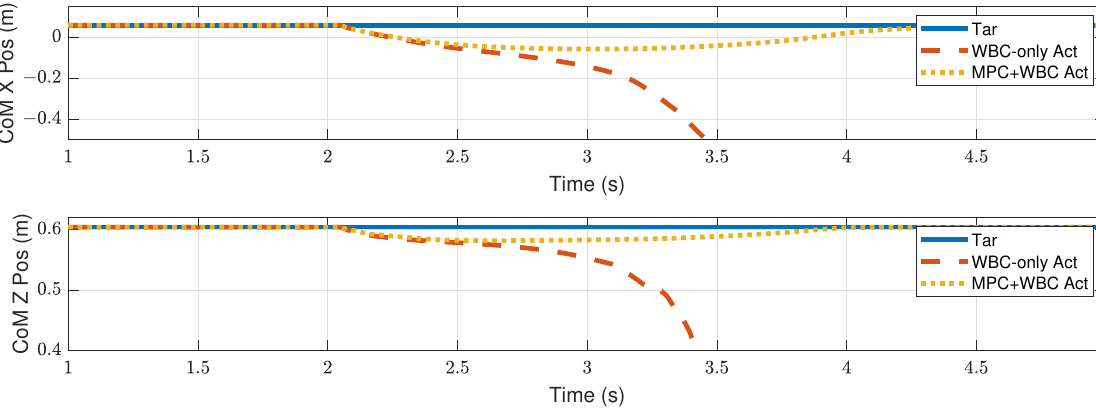
Figure 5. CoM position of the robot under the frontal impact of an 11 kg rigid ball.